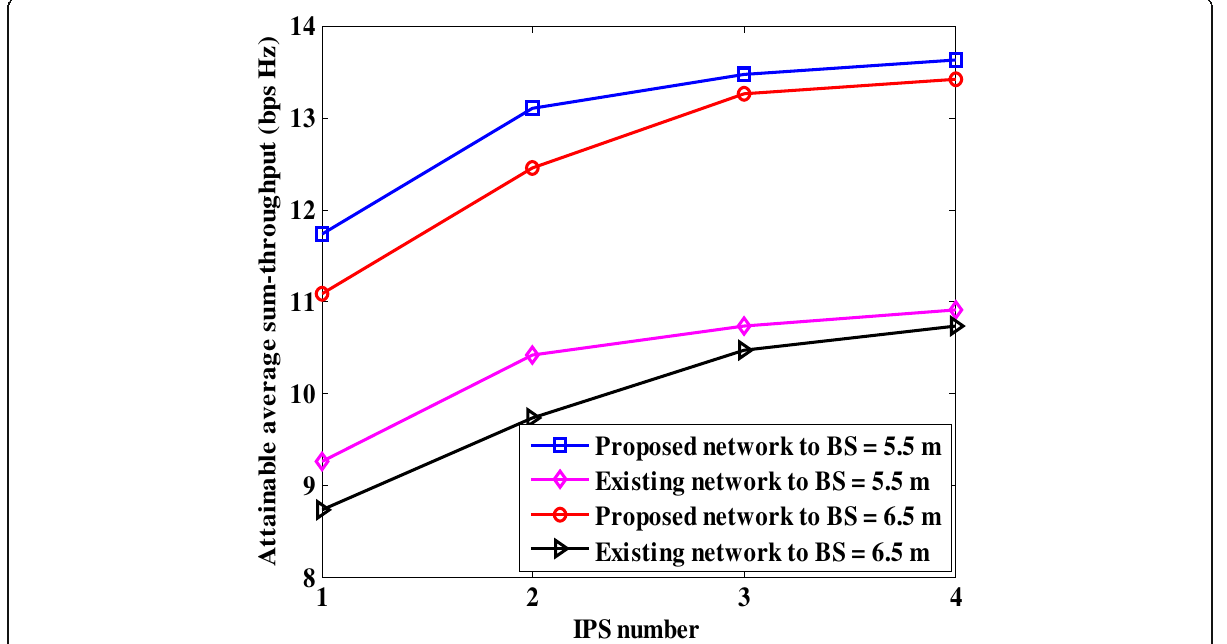
Fig. 8 Attainable average sum-throughput based on unequal network